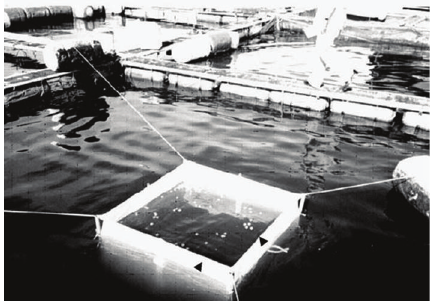
Figure 2: Experimental mesocosm used in Nakdong River, Korea